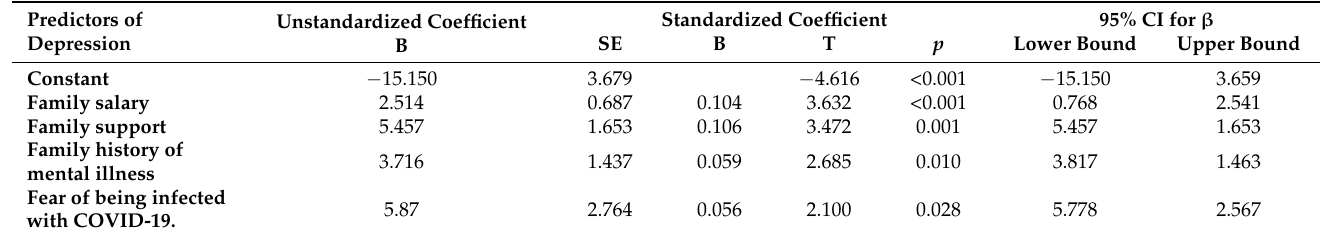
Table 5. Linear regression model of sociodemographic characteristics that predict depression.